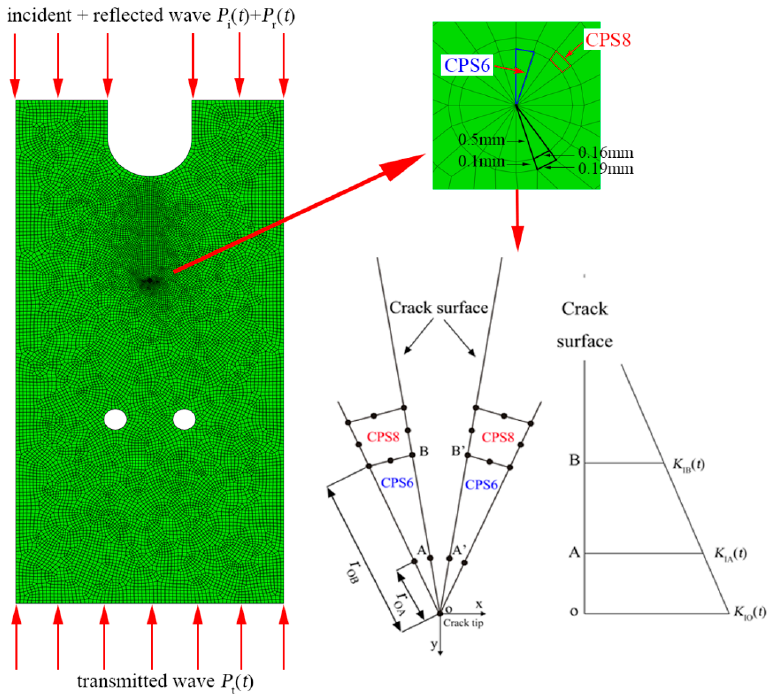
Figure 13. Mesh of finite element model established in ABAQUS code.